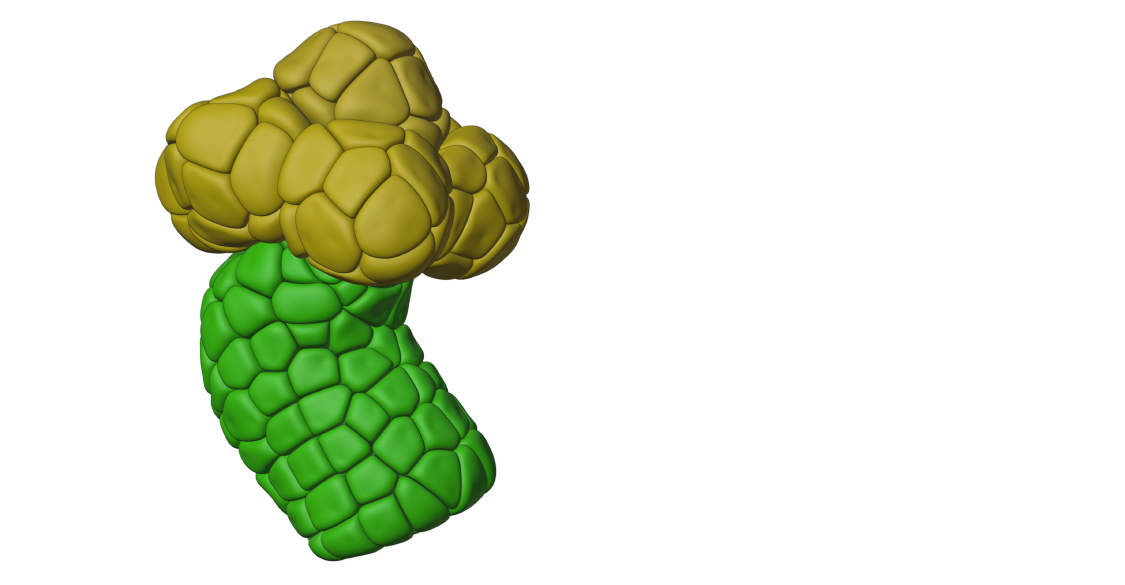
Figure 3. Artificial cells of a “mini-gland” subset of a salivary gland. This subset, which is replicated many times in a real salivary gland, forms the upstream beginning site of saliva production. Acinar cells are shown in yellow colour, duct cells are shown in